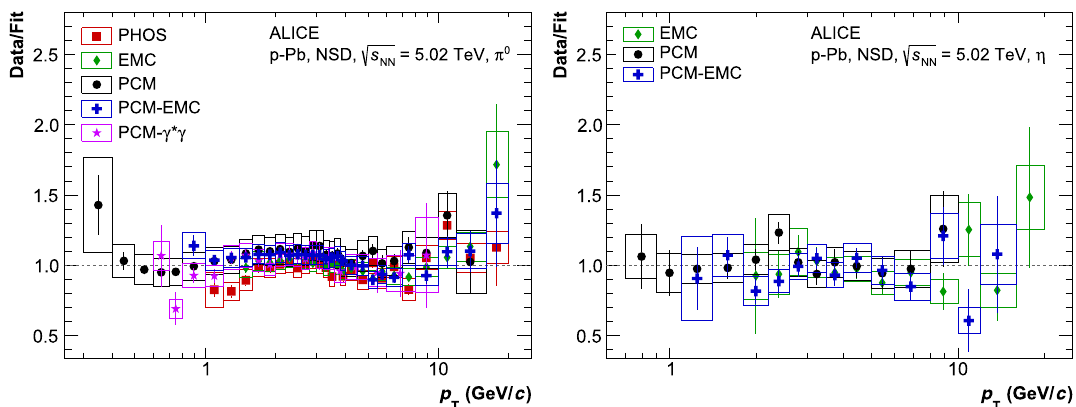
Fig. 6 Ratio between individual π 0 (left) and η (right) invariant differential yield measurements, and Tsallis fit to the combined meson yield. The statistical uncertainties are represented as vertical error bars whereas the systematic uncertainties are shown as boxes